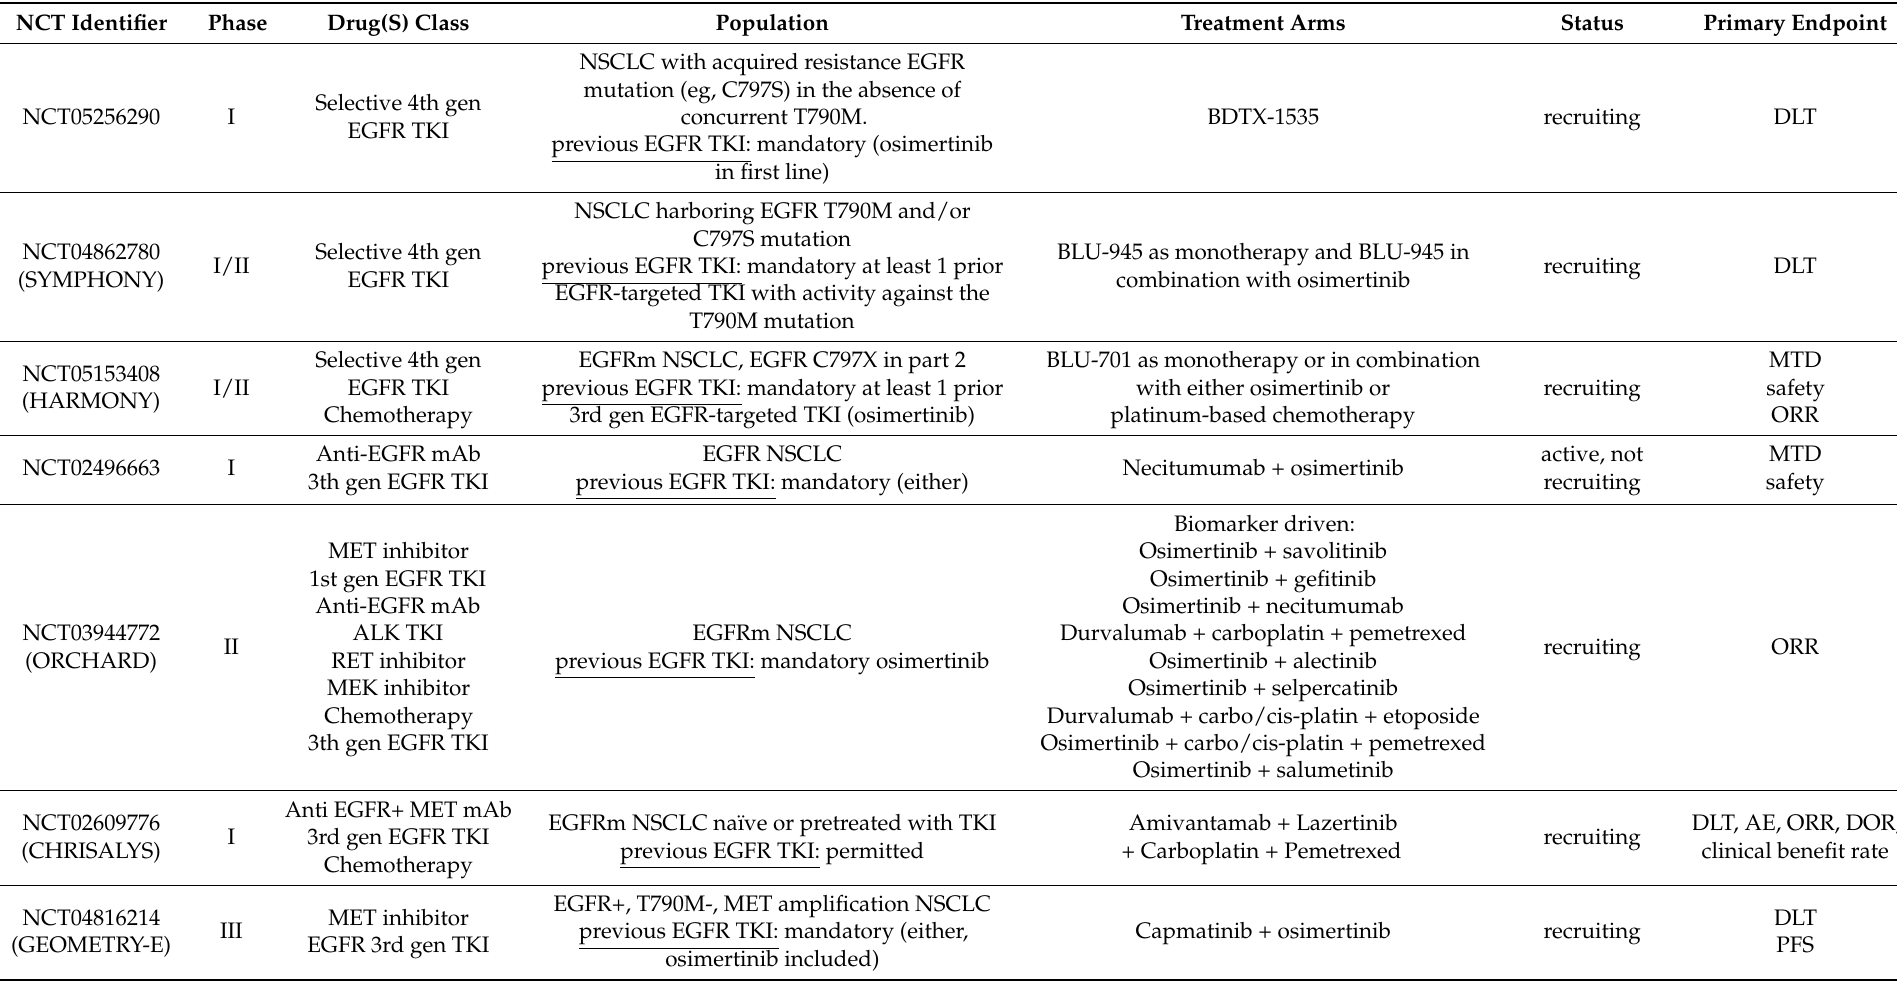
Table 1. Selection of ongoing clinical trials in osimertinib-pretreated EGFR-mutated advanced